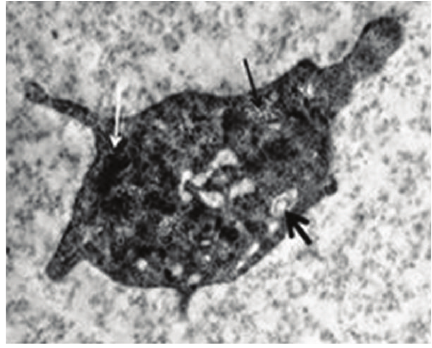
Figure 3: Dense bodies are absent in platelets with electron microscopy. Glycogen deposit area (thin arrow), open canalicular system (thick arrow), and electron-dense areas are not surrounded by membrane (white arrow), as observed in platelet